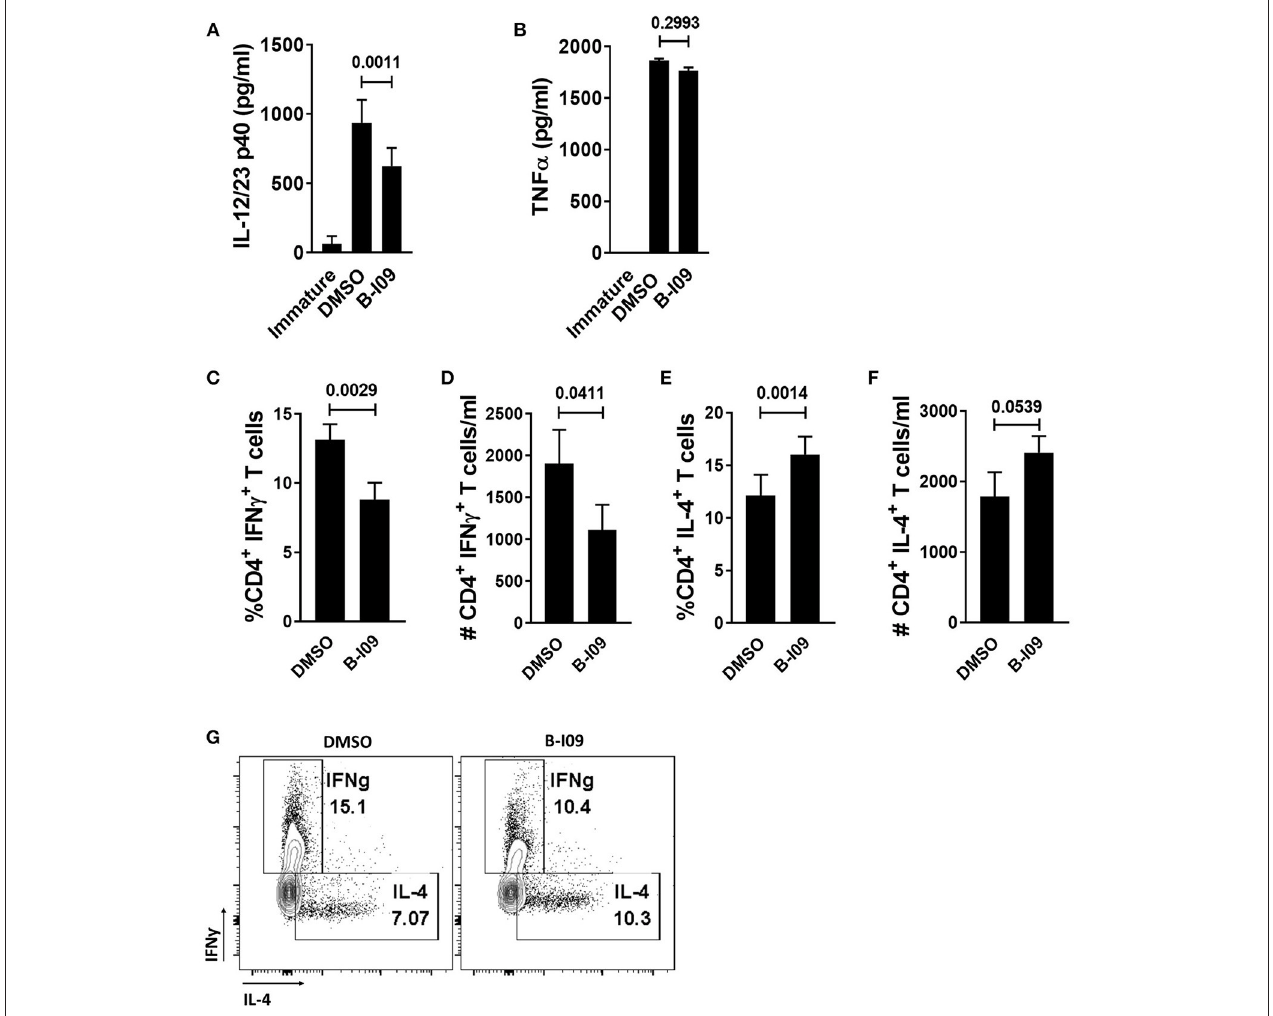
FIGURE 2 | XBP-1s inhibited moDCs reduce Th1 differentiation . (A,B) ELISAs were used to determine the concentration of IL-12/23 p40 cytokines or TNF α in the supernatants of B-I09- or DMSO-treated moDCs after 24h of LPS stimulation. Replicate means from 8 (IL-12/23 p40) and 2 (TNF α ) independent experiments are shown, Dunnett’s test. (C–G) T cells were cultured with B-I09 or DMSO pre-treated moDCs (moDC:T cell ratio of 1:30), and additional B-I09 (20 µ M) or DMSO (0.1%) was added once on day 0. Harvested T cells were evaluated on day + 5 for Th1 (CD4 + , IFN γ + ) and Th2 (CD4 + , IL-4 + ) phenotype. Percentage or absolute numbers of Th1 (C,D) and Th2 (E,F) are shown. (G) Representative contour plots show CD4 + Th1 vs. Th2 cells on day + 5 of the allogeneic co-culture. Means of 8 independent experiments are shown, paired